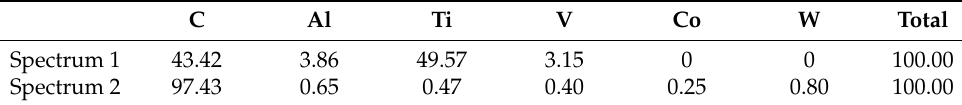
Figure 11. The conventional drill effect on the rake face after drilled hole number 50. Table 2. The EDS analysis for the selected points, as shown in Figure